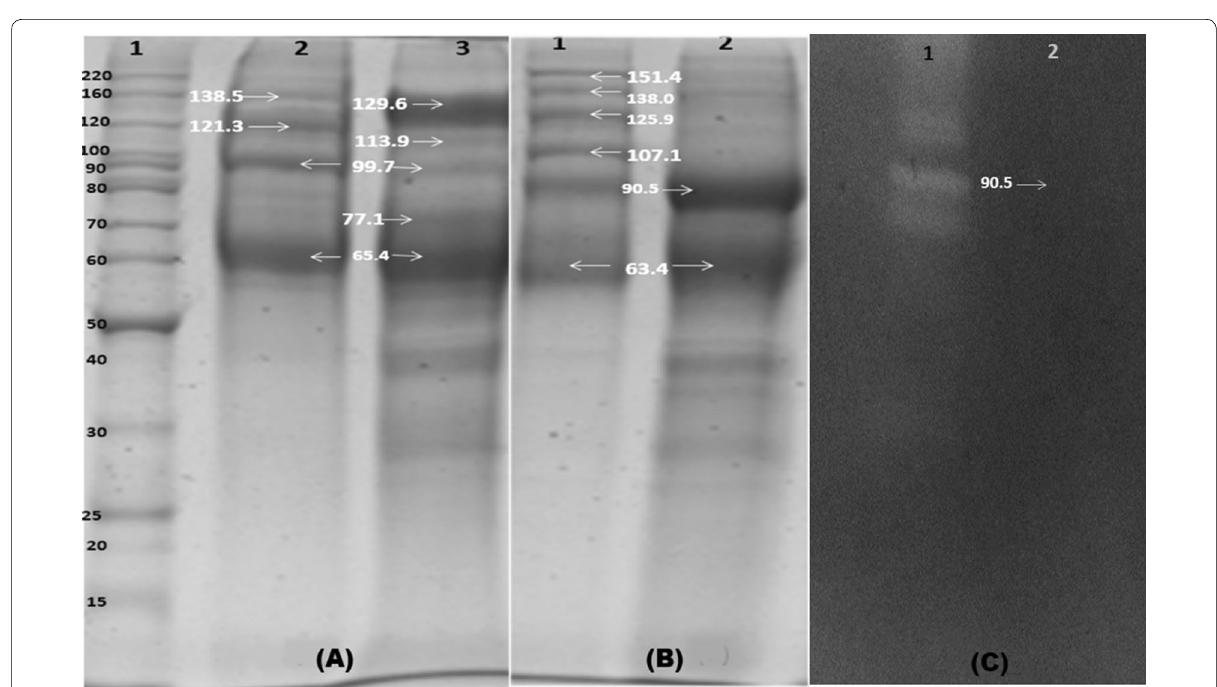
Fig. 5 Coomassie Blue stained 10% SDS-PAGE gel image showing the protein profiles under A reducing B non-reducing conditions c zymogram for activity bands of partially purified protein eluted by Sephacryl S-200HR column. In panel ( A ), Lane 1 is the standard molecular weight (MW) marker protein and lane 2 and 3 represents the peak II and III proteins subjected to 2 Mercaptoethanol treatment. Shifting of the high intense band in lane 3 indicated the presence of disulfide bond in the protein. In B , lane 1 and 2 represents peak II and III proteins without 2 ME treatment. C represents the zymogram showing the phytase activity. Lane 1 clearance zone denoted by positive standard phytase ( E. coli produced recombinant phytase of A niger ) and lane 2, though the clearance zone could not be captured, the phytase activity band was observed at the arrow